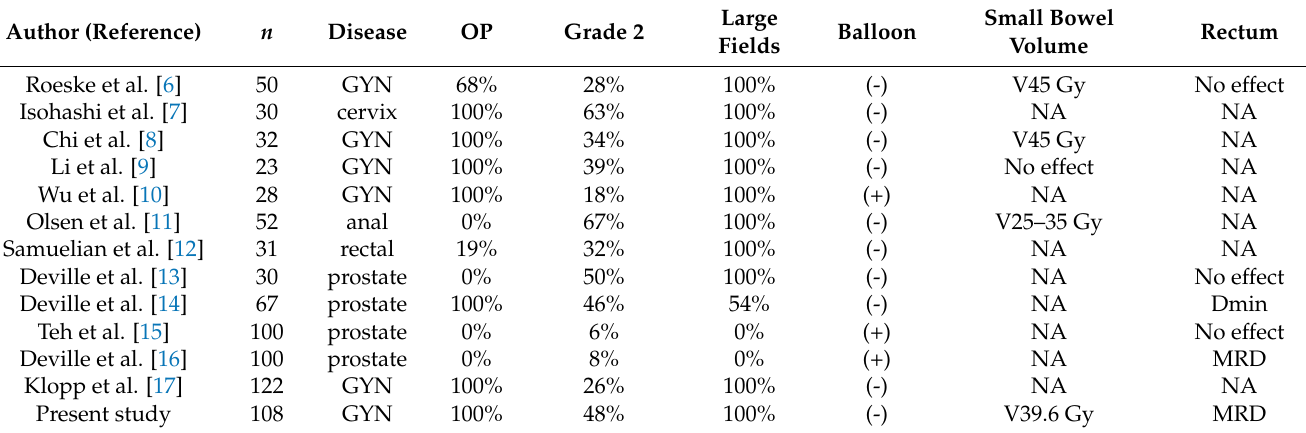
Table 5. Literature review of acute GI toxicity in patients undergoing IMRT pelvic